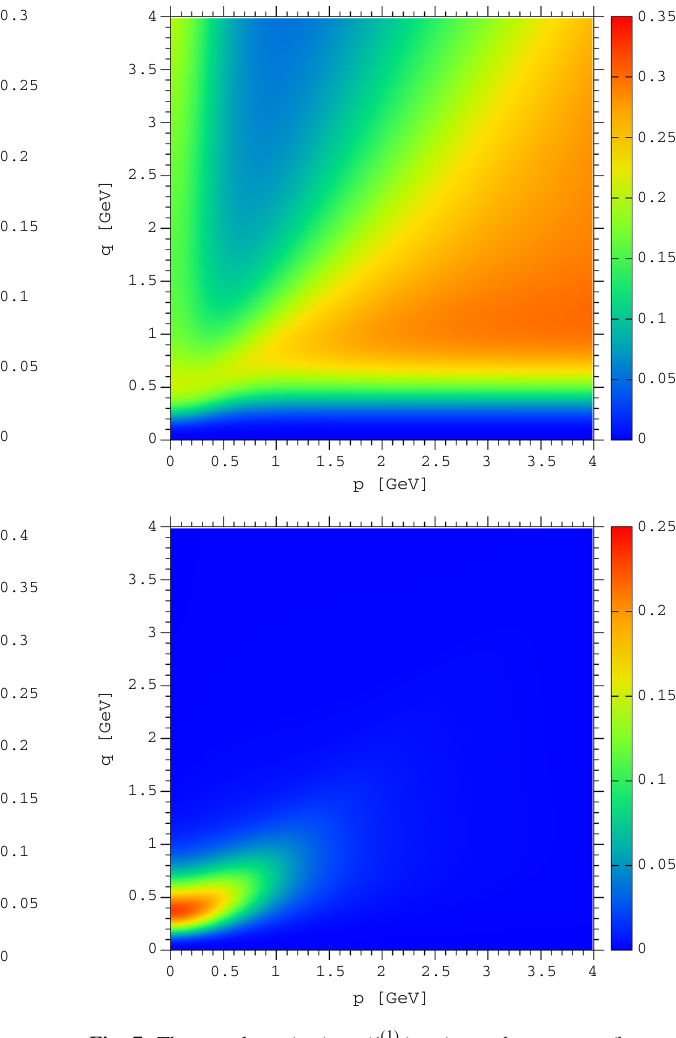
( p , q ) and vector (bottom) B